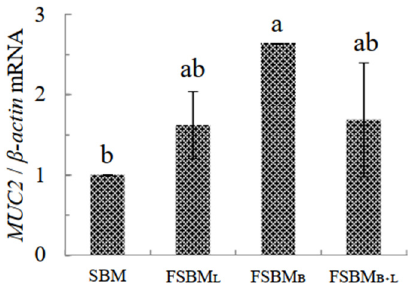
Figure 6. Effect of two-stage FSBM on jejunum’ s relative mRNA expression of genes related to MUC2 of 35 day-old broilers. Each value represents the mean ± standard deviation (n = 5). a, b Means within a row with different letters differed significantly ( p < 0.05). SBM: Soybean meal; FSBM L : commercial control; FSBM B : SBM one-stage fermented by Bv; FSBM B+L : SBM two-stage fermented by Bv and Lb. Table 6. Evaluation of the economic benefit of two-stage FSBM supplemented in diet. Item